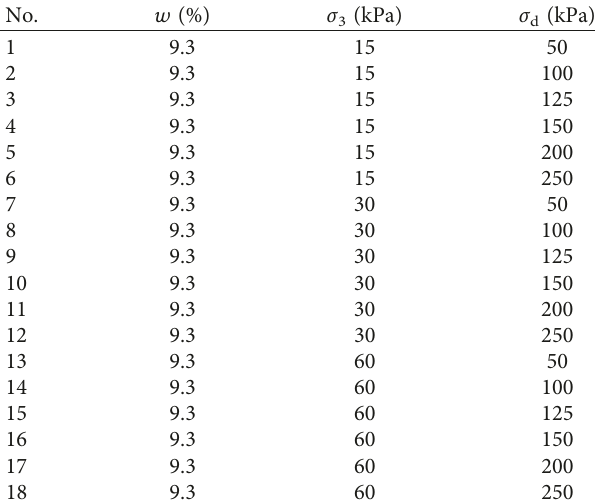
Table 4: Cyclic triaxial test program.